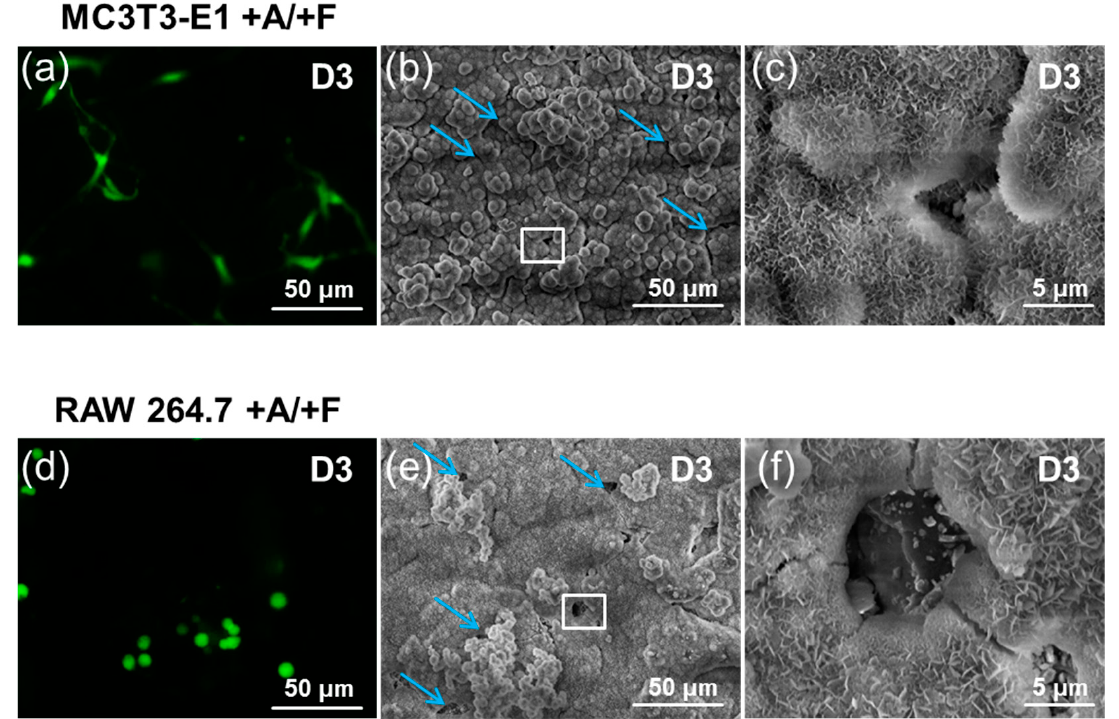
Figure 9. SEM imaging of (+A/+F)-bCaP(24 h) with either MC3T3-E1 or RAW 264.7 cells: ( a ) day3 LIVE ® staining of MC3T3-E1 on +A/+F AntiA-bCaP(24 h)-FGF2; ( b , c ) low and high magnification SEM of AntiA-bCaP(24 h)-FGF2 after three days of MC3T3-E1 culture; ( d ) day three LIVE ® staining of RAW 264.7 cells on AntiA-bCaP(24 h)-FGF2; and ( e , f ) AntiA-bCaP(24 h)-FGF2 after three days of RAW 264.7 culture. The white squares indicates the areas shown at higher magnification to the right of the image. Blue arrows point to other openings in the bCaP coatings similar to those in the higher magnification image outlined in the white